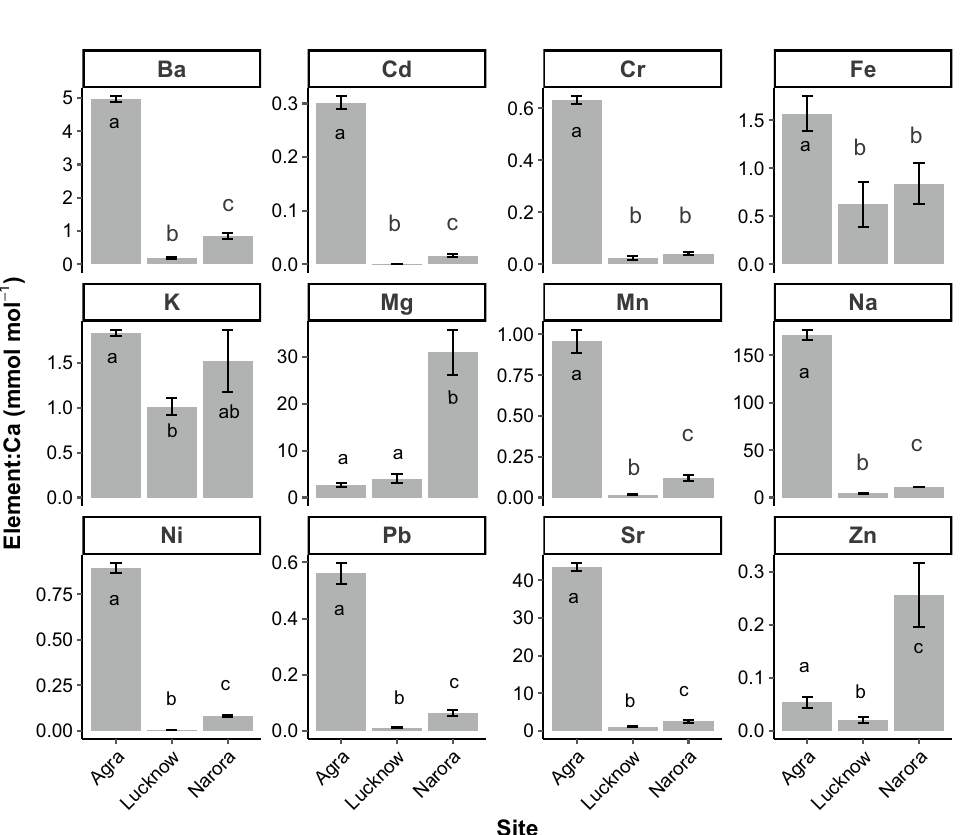
Figure 5. Mean otolith element concentrations (mmol:mol Ca) for each of the three populations. Error bars show 1 standard error. Within a subplot, bars which do not share a common letter are clearly different (MGLM analysis: P < 0.05). For univariate GLM results see Table